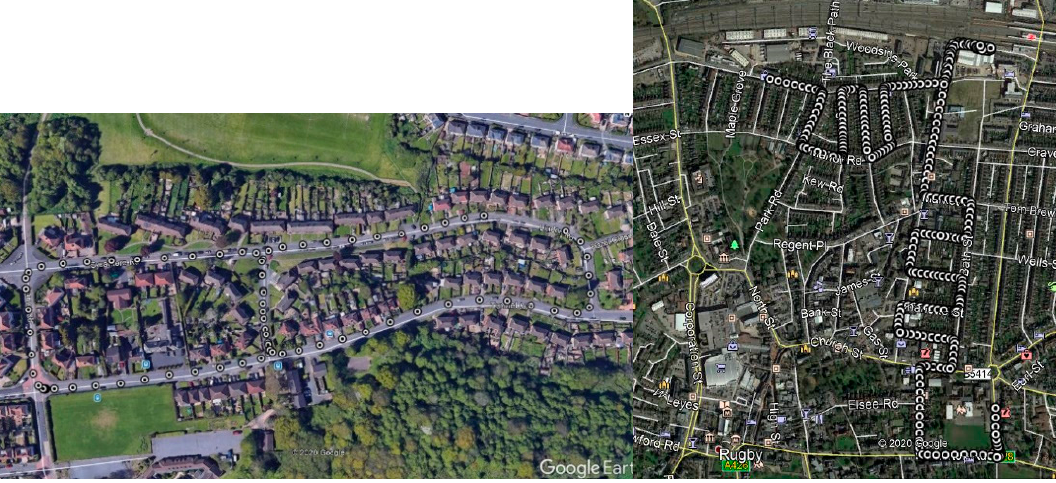
Figure 13. Trajectory of V-Vw8 sharp cornering and successive left and right turns data subset of the IO-VNBD.